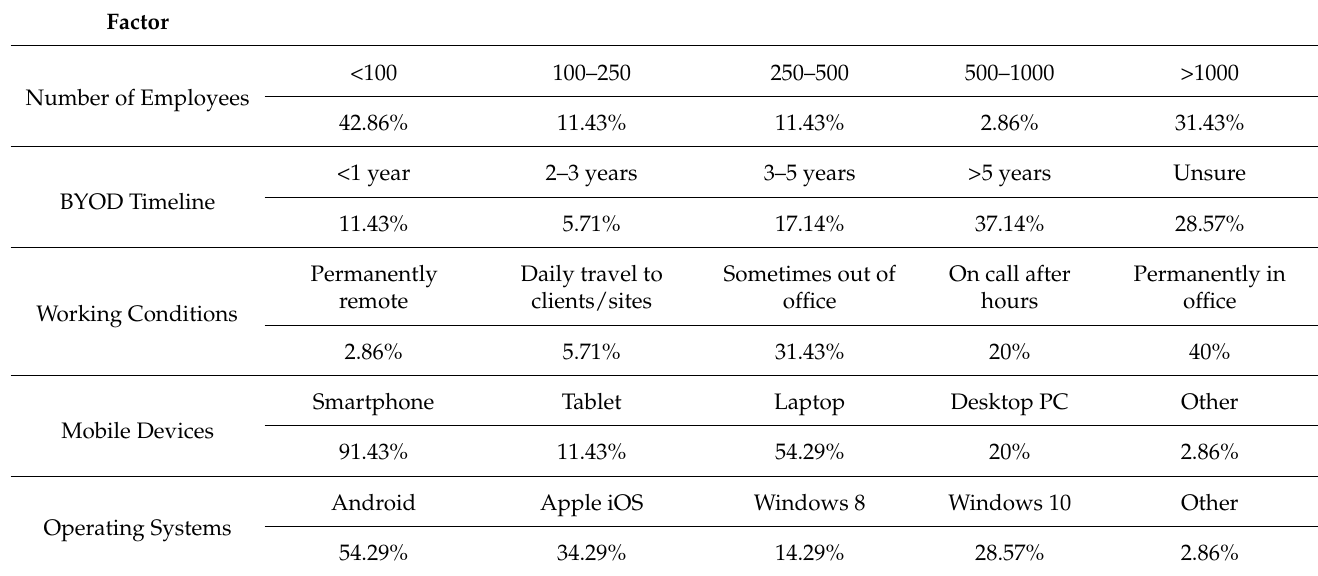
Table 2. Comparison of environmental factors and hardware influencing BYOD